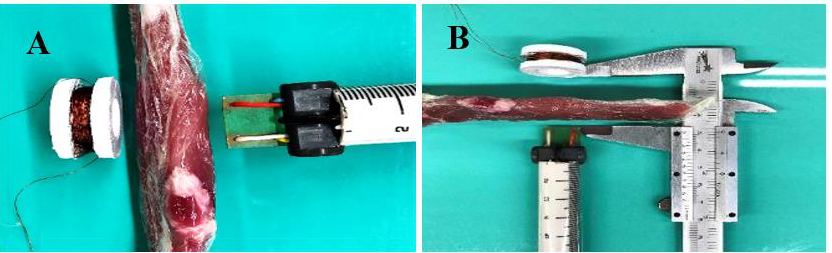
Figure 3. Evaluation of magnetic permeability of the magnetic field by biological tissue, with ( A ) coil on the left, biological tissue in the center and tip of the field analyzer on the right; In ( B ), the caliper used to measure the distance from the coil to the analyzer.